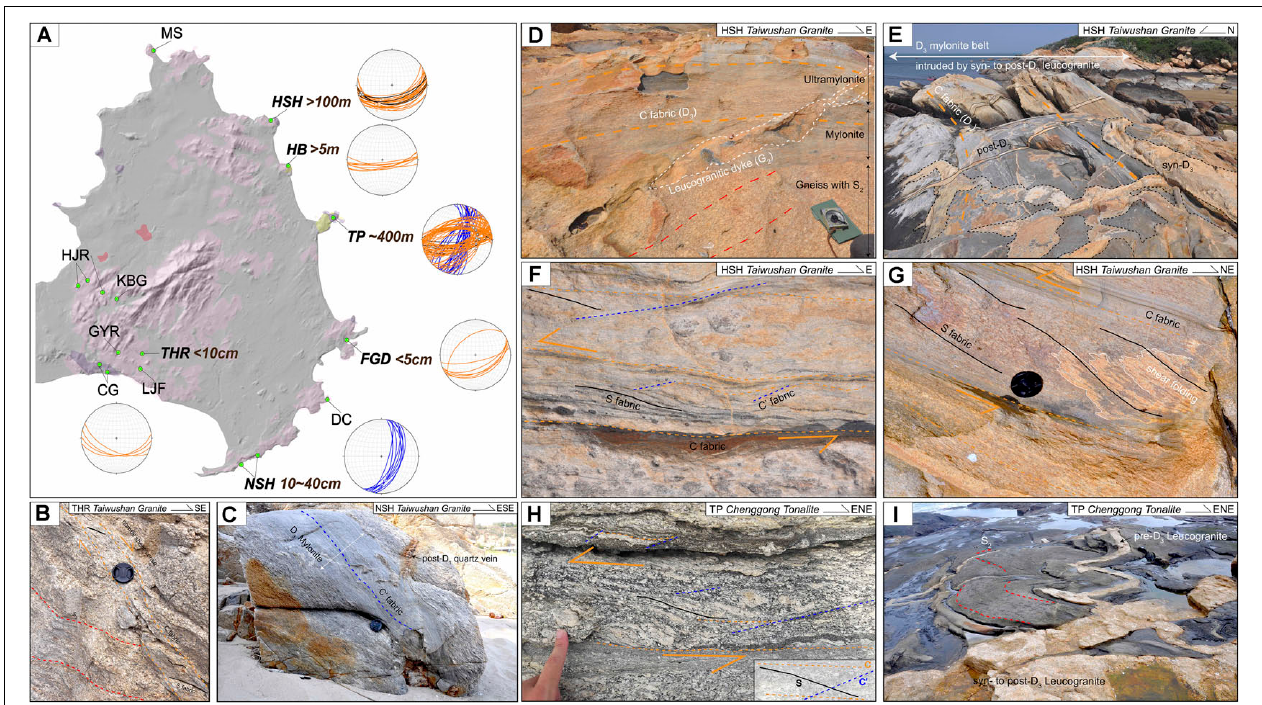
FIGURE 7 | Topographic map overlaid by the geological map showing outcrop photos with measured D 3 shear fabrics and mineral lineation plotted with equal area southern hemisphere stereonet projection. The bold italic words indicate the sample locations with D 3 shear fabrics identified. (A) Topographic map with geological map showing the sample locations with D 3 shear zone developement. The brown numbers show the width of the shear zone. (B) S/C fabric with normal shear sense crosscuts the subhorizontal S 2 foliation within Taiwushan Granite at THR. (C) D 3 mylonite (C’ surface) crosscuts the post-D 1 quartz vein within Taiwushan Granite at NSH. (D) D 3 shear zone (C fabric) development from mylonite to ultramylonite crosscutting the S 2 fabric, both of which are intruded by leucogranitic dike (G 2 ) within Taiwushan Granite at HSH. (E) D 3 mylonite belt intruded by syn- to post- D 3 leucogranite (G 2 ) within Taiwushan Granite at HSH. (F) S/C/C’ fabric showing sinistral shear sense within Taiwushan Granite at HSH. (G) S/C fabric indicating sinistral shear sense with shear folding along the S fabric within Taiwushan Granite at HSH. (H) S/C/C’ fabric showing sinistral shear sense within Chenggong Tonalite at TP. (I) Subhorizontal S 2 fabric and pre-D 3 leucogranite (G 2 ) folded during D 3 , both of which are intruded by syn- to post-D 3 leucogranite (G 2 ) at TP.